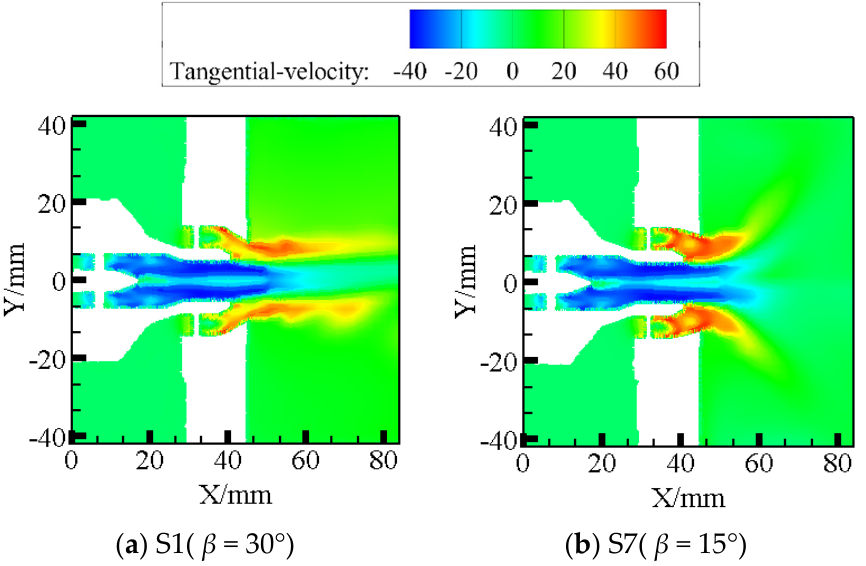
Figure 18. Tangential velocities contours under different sleeve angles.